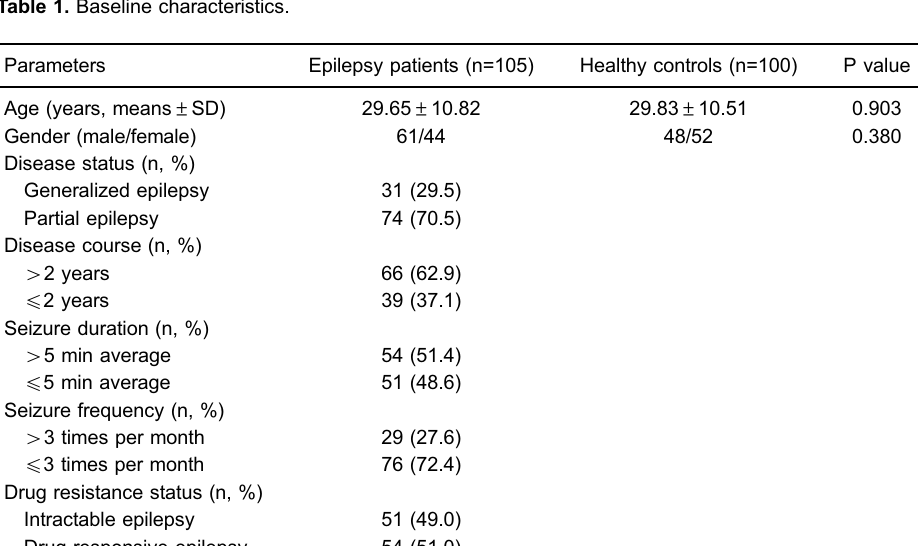
Table 1. Baseline